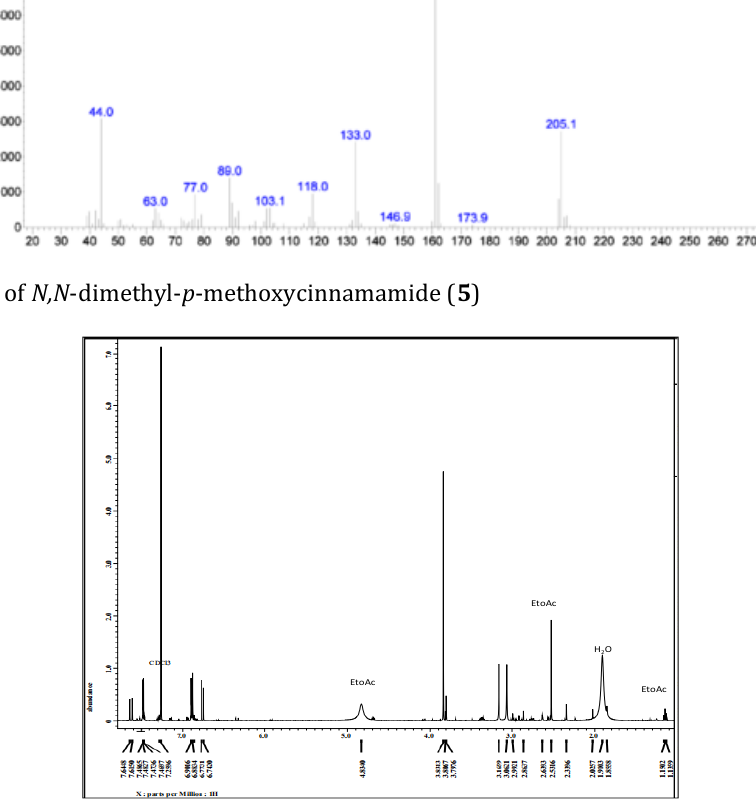
Figure 6. The NMR spectrum of